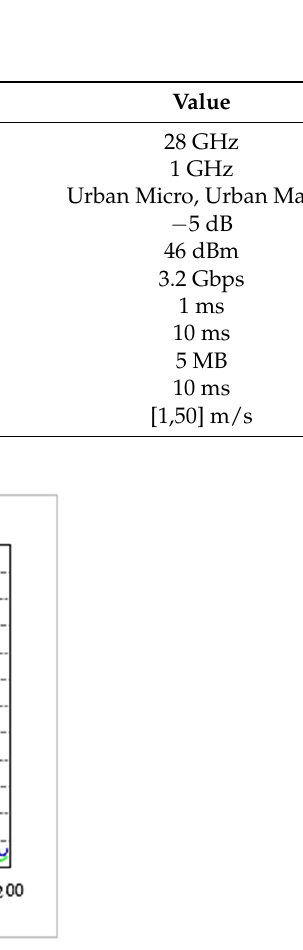
Figure 5. Number of wasteful HO as a function of the number of training episodes for DDPG only HO scheme.